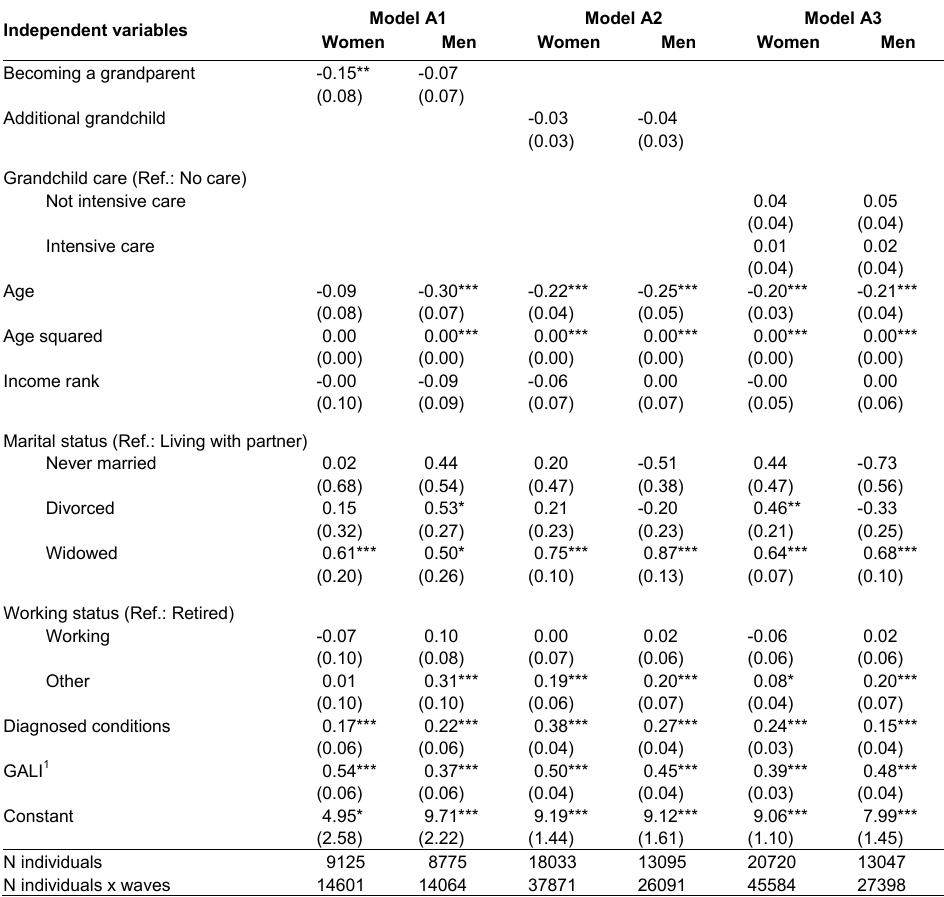
Table A1 : Linear fixed-effects models for the effect of becoming a grandparent (Model A1), having an additional grandchild (Model A2), and providing grandchild care (Model A3) on depressive symptoms (different specifications or selections compared to models in Table 3 in the